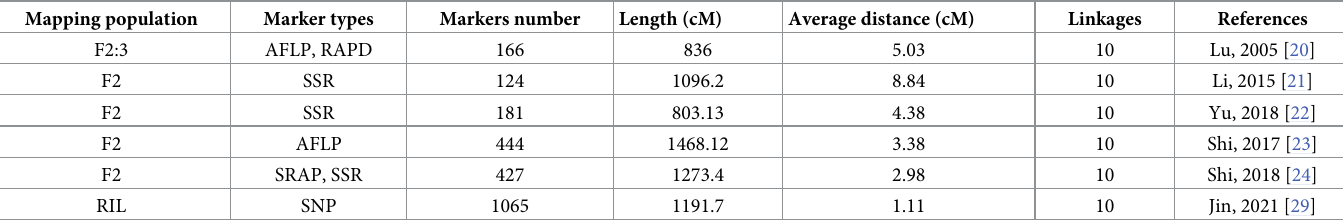
Table 5. Statistics of the existing map of sorghum-sudangrass hybrid. Mapping